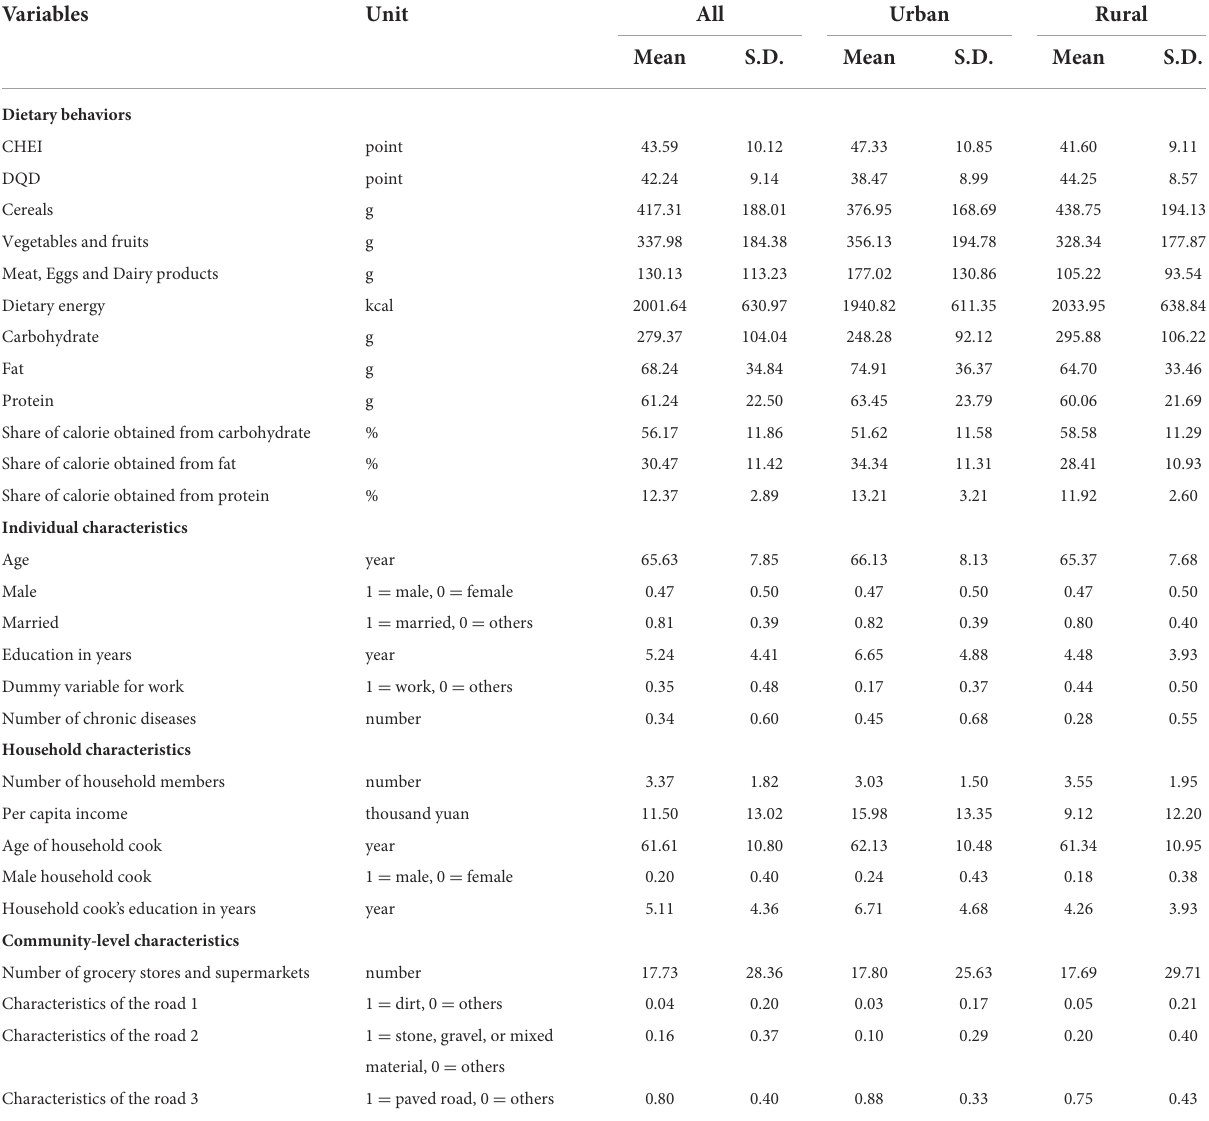
TABLE 2 Summary